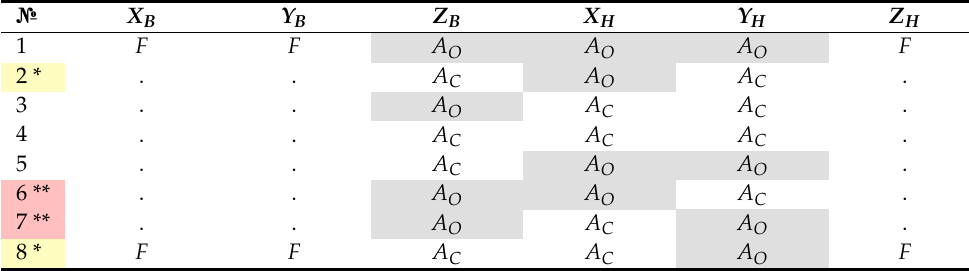
Table A3. Fixed axes X B , Y B , Z H and actuated axes X H , Y H , Z B . № X B Y